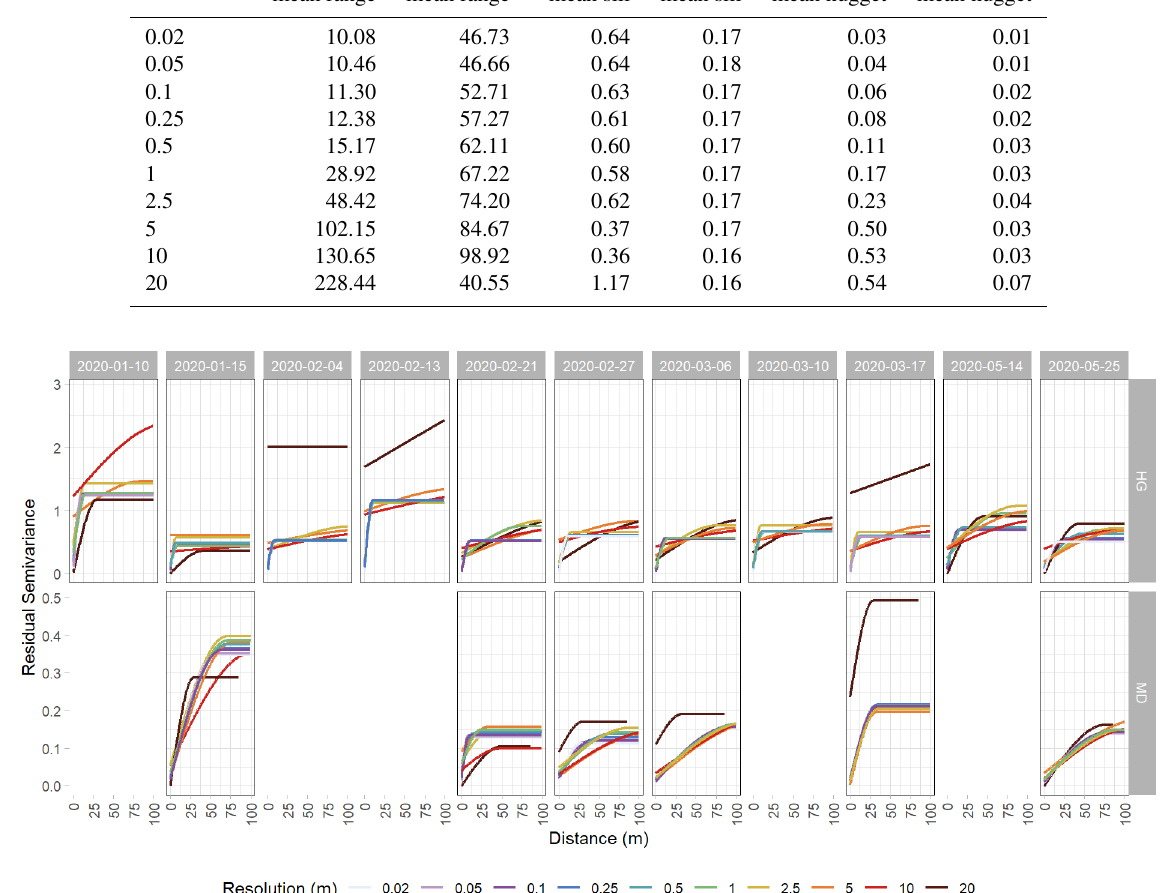
Figure 4. Spherical-fit variogram models of detrended snow depth residuals from the Hourglass (HG) and meadow (MD) using the nearest- neighbor resampling method. Each panel depicts a specific observation day and colors represent different snow depth DSM resolutions. Five observation days were removed from the meadow site time series due to poor model quality. Note different y axis scales for the HG and MD